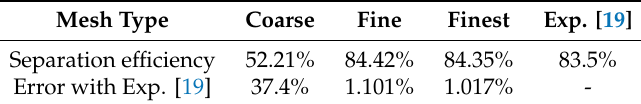
Table 4. Grid dependence test results.